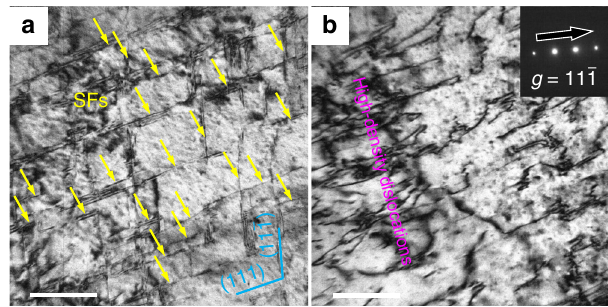
Fig. 4 Microstructure of the CRAA sample after tensile testing. a TEM BF image taken from near 〈 110 〉 axis, showing nano-spaced SFs (yellow arrows). b TEM BF image showing high density dislocations. Scale bars in a and b are both 100